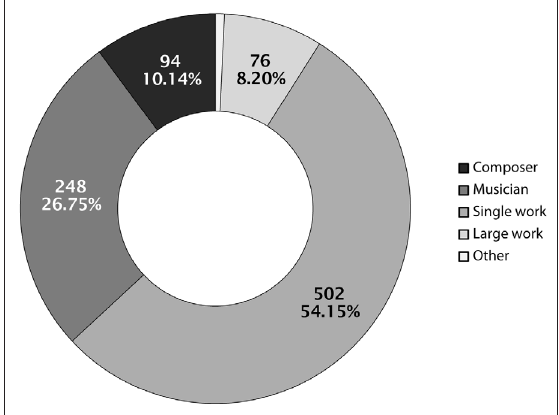
Figure 4: Total number of references to composers, musicians, and works of music across all of Pynchon’s